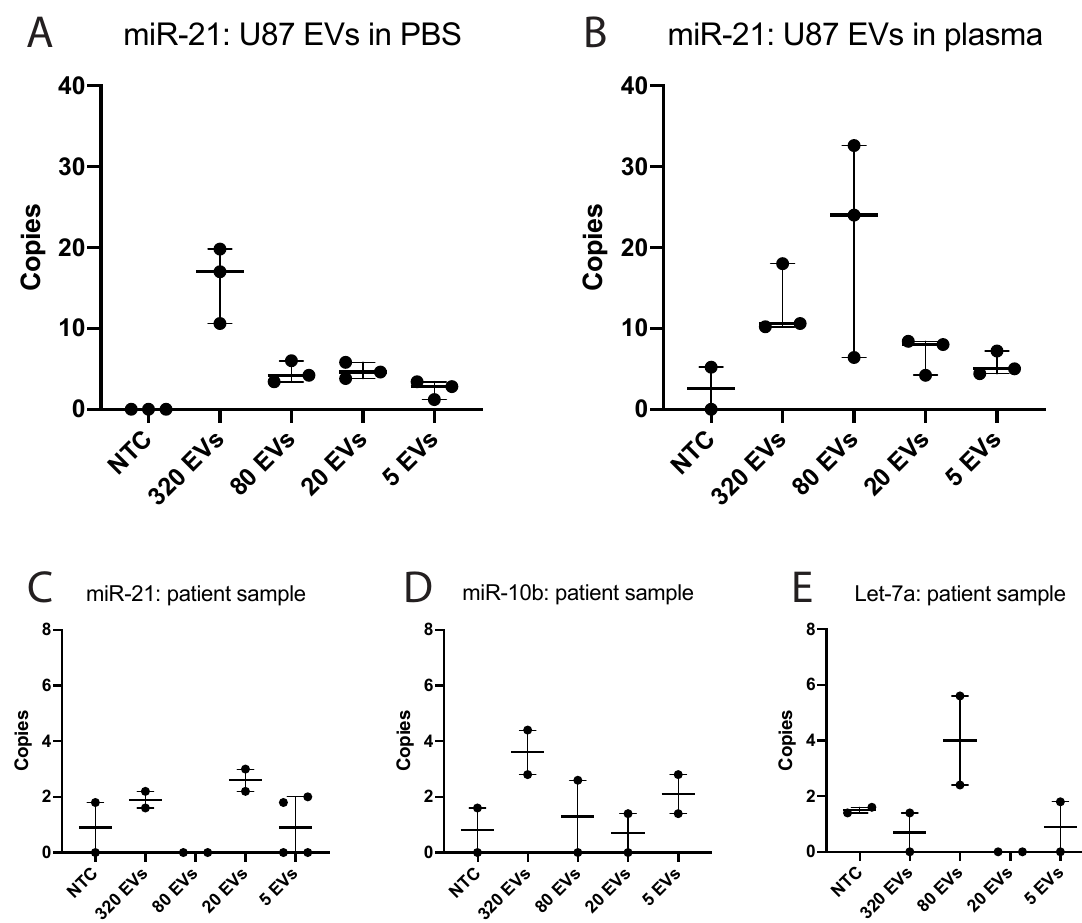
Figure 3. ddPCR analysis of PpIX-positive EVs. ( A ) Number of copies of miR-21 found in the indicated number of sorted PpIX-positive EVs from U87 cells treated with 5-ALA. EVs isolated by ultracentrifugation were diluted in PBS and sorted with high-resolution flow cytometry. NTC: non-template control. EVs: extracellular vesicles. ( B ) Number of copies of miR-21 found in the indicated number of sorted PpIX-positive EVs from U87 cells treated with 5-ALA. EVs